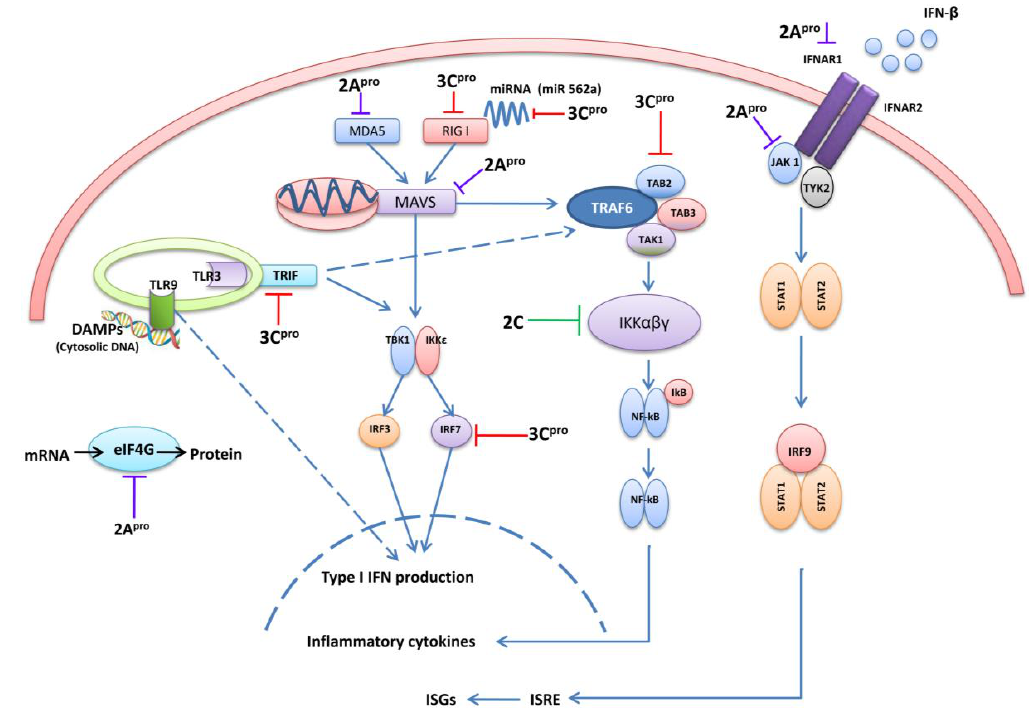
Figure 2. A graphical illustration of EV71 evasion strategies in cellular signaling pathways. EV71